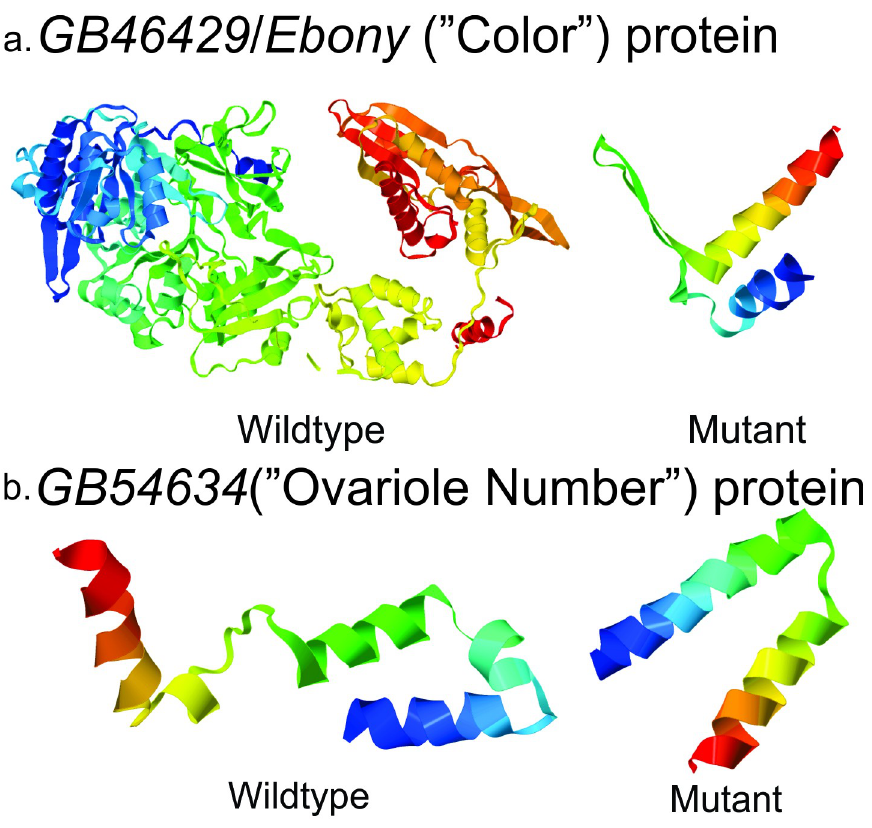
Fig 2. Predicted protein structure (Phyre2) for both wild type and discovered variants of genes. a. GB46429 (Ebony) , correlated to both scutellar plate and tergite color phenotypes., and b. GB54634 , correlated to ovariole number.